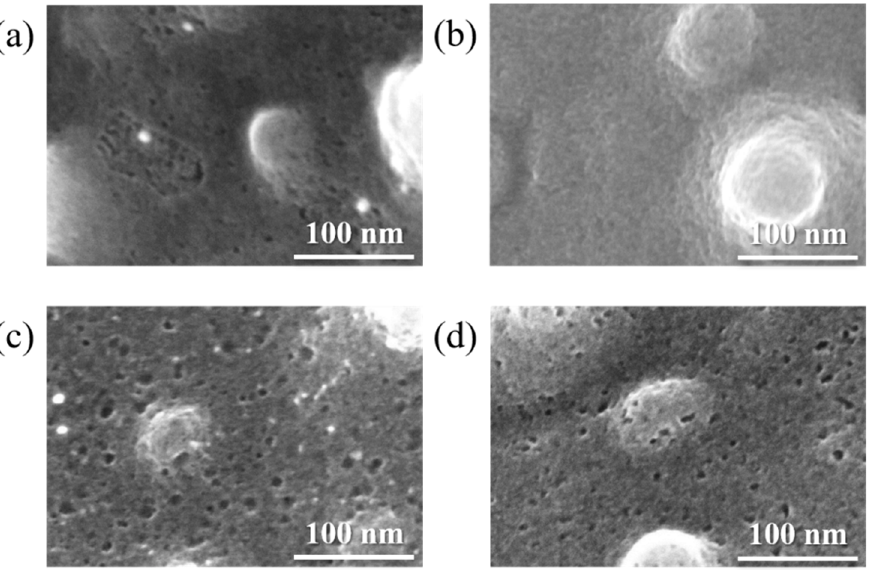
Figure 3. High-magnification scanning electron microscope images of films of woody carbon ma- terial. ( a ) Untreated surface. Vacuum-ultraviolet-treated films of woody carbon material at ( b ) high 𝑃 (cid:3016)(cid:2870) , ( c ) median 𝑃 (cid:3016)(cid:2870) , and ( d ) low 𝑃 (cid:3016)(cid:2870) .